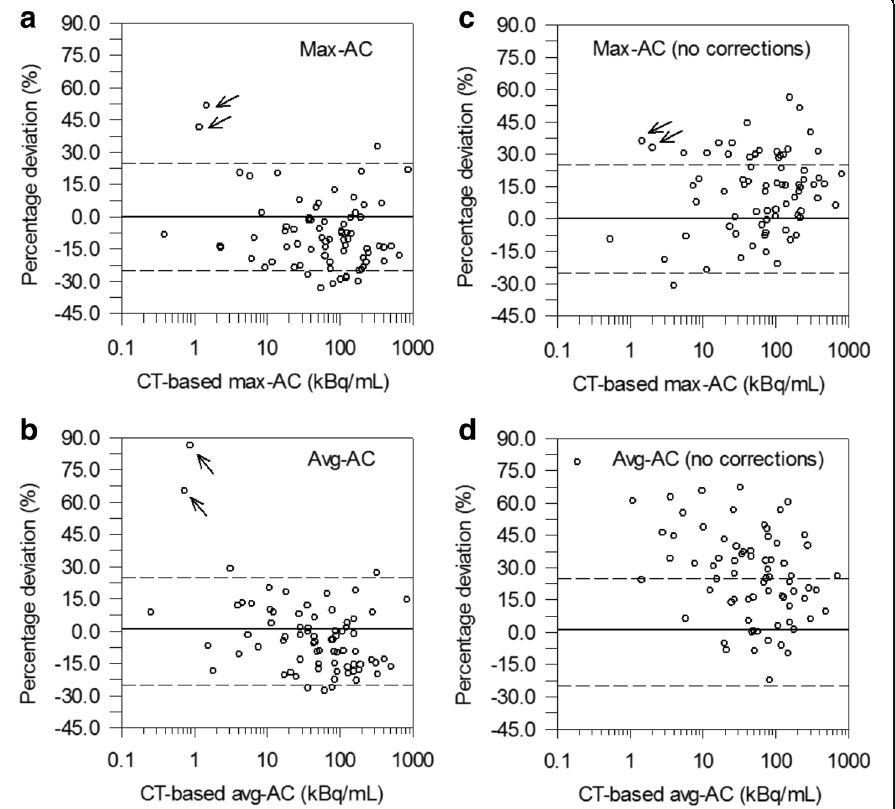
Fig. 1 Percentage deviations between MR-based and CT-based ACs as a function of the CT-based max-AC and avg-AC with ( a , b ) and without corrections ( c , d ). Two outliers are marked with arrows. In panel d , the deviations of the outliers (98 and 142%) are beyond the axis scale and are not shown. Solid (dashed) lines represent the zero (± 25%) percentage